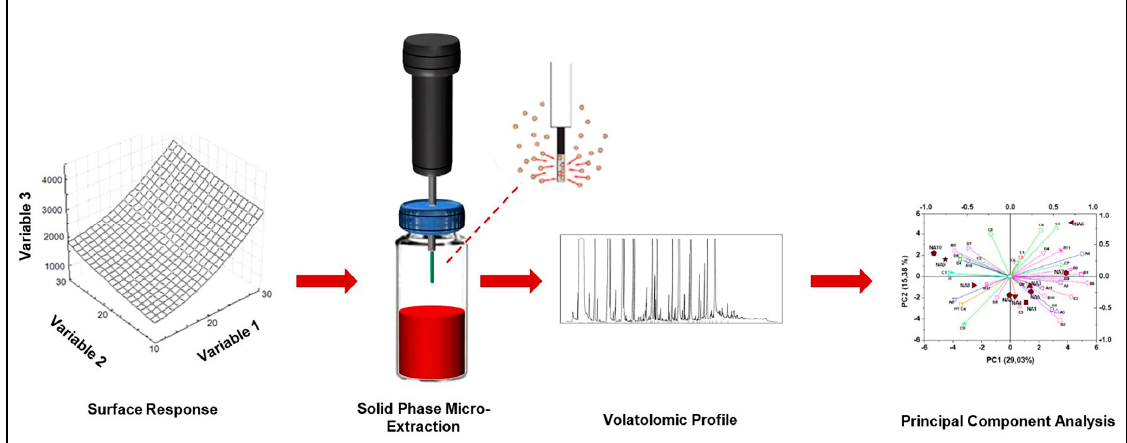
Figure 2. Optimization of Headspace Solid Phase Microxtraction (HS-SPME) parameters with a multivariate statistical analysis.